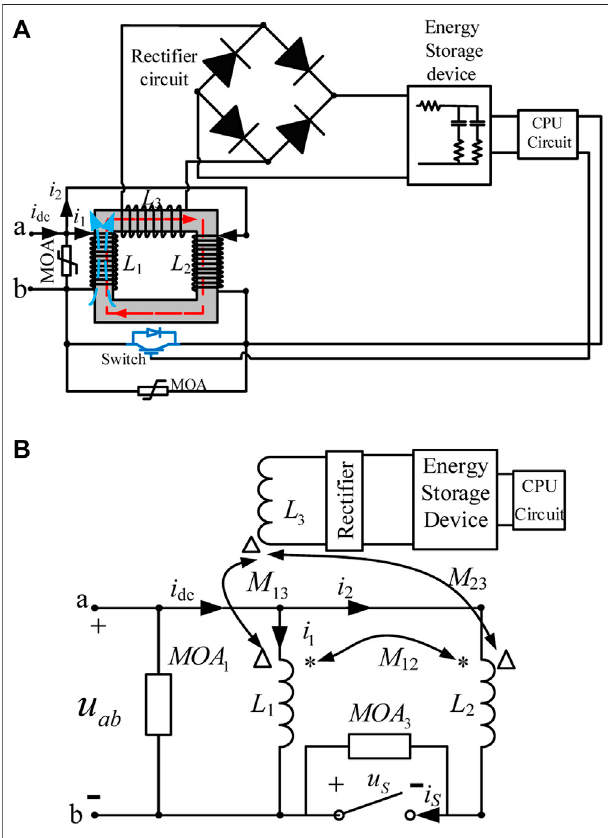
FIGURE3| StructureofthePCCSSFCLwithSPSS. (A) Con fi gurationof the PCCSSFCL with SPSS. (B) Equivalent circuit of the PCCSSFCL with